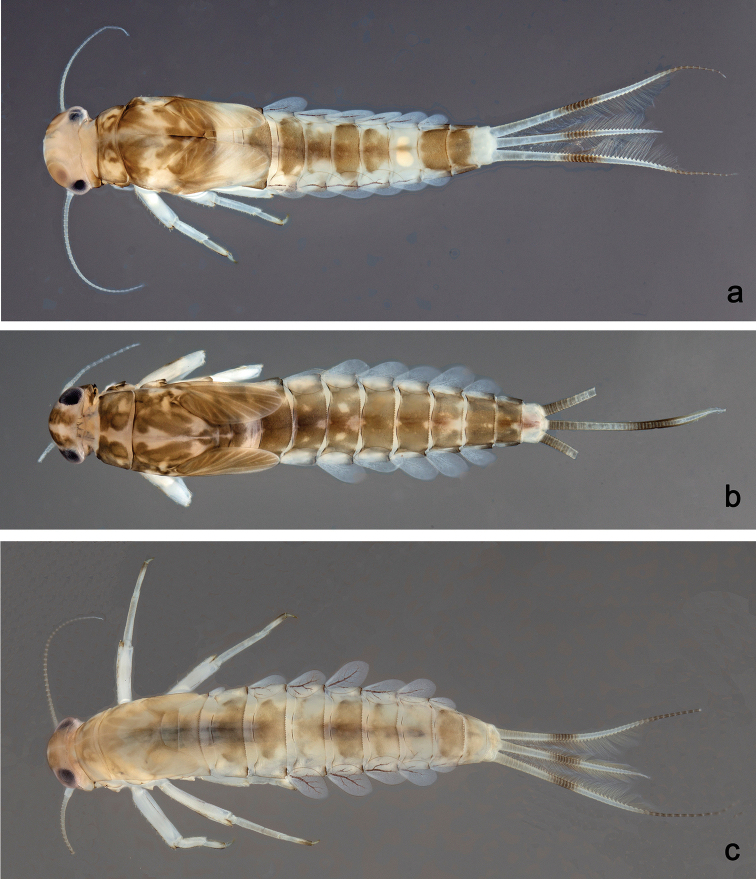
Habitus, larvae, dorsal view aLabiobaetis
gamay sp. nov. bLabiobaetis
pangantihoni sp. nov. cLabiobaetis
tagbanwa sp. nov.